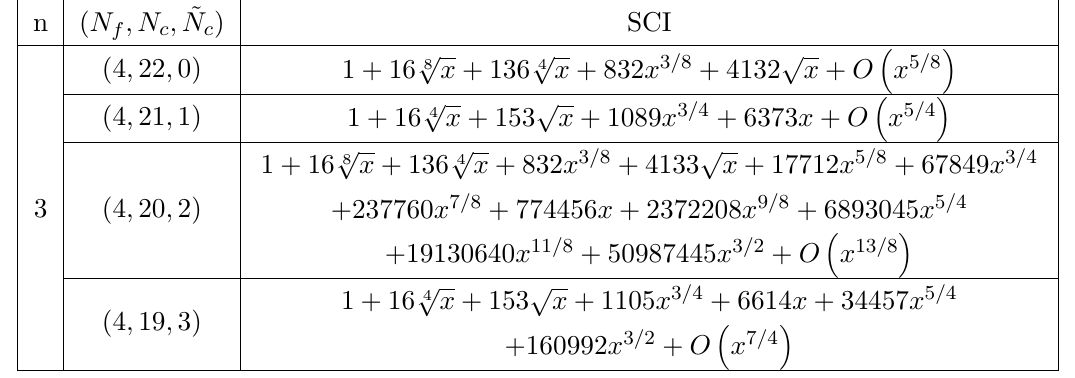
+ V − . 0 , 0 0 , 0 ) = (3 , 3) are f